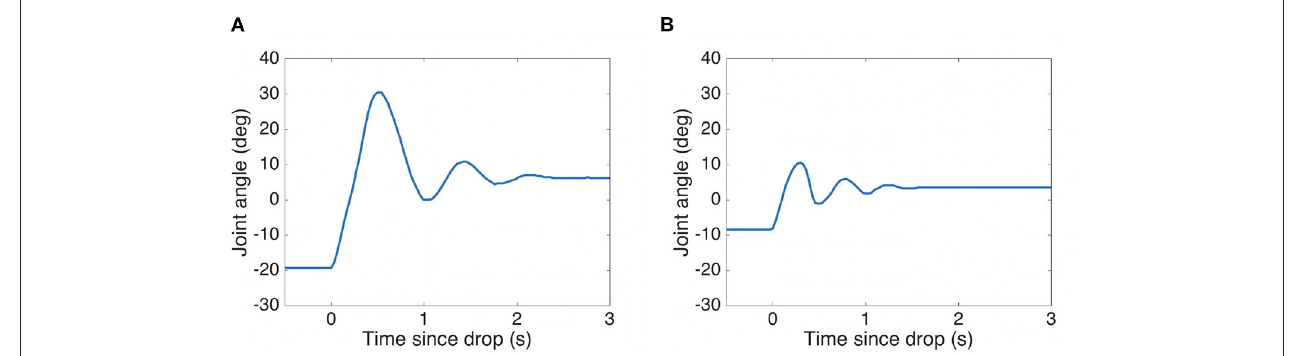
FIGURE 8 | Elbow response to 1 kg mass release for two levels of co-contraction. See Figure 7 for the corresponding arm movement image series. (A) 25% co-contraction (B) 100% co-contraction.